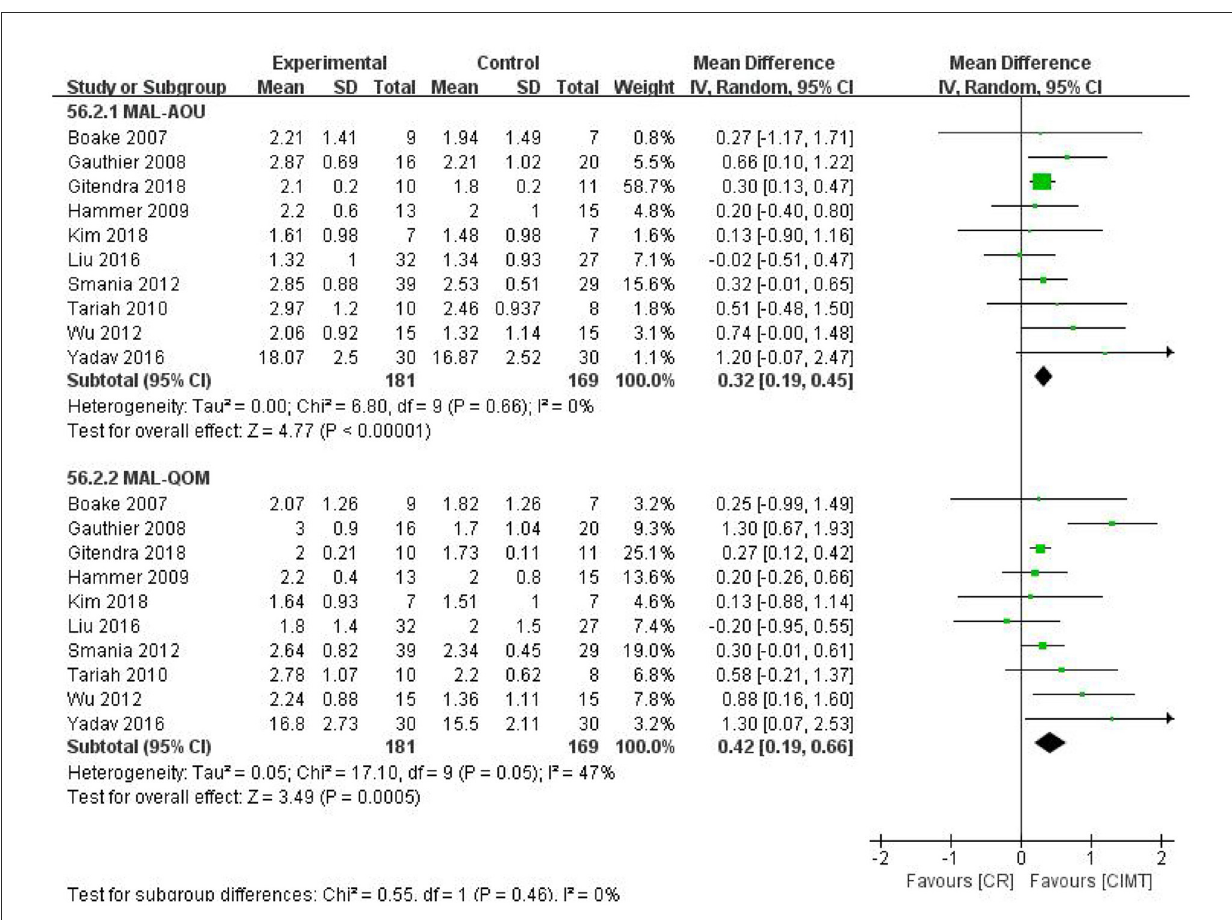
FIGURE5 The forest plot of MAL comparing CIMT and